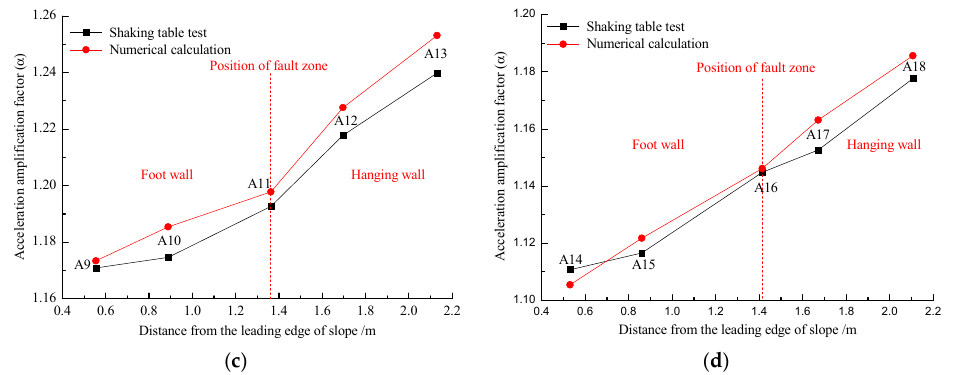
Figure 13. Comparison of AAFs between shaking table test and numerical simulation under influence of Minxian wave, with input PGA of a = 0.1 g at ( a ) slope surface, ( b ) vertical section, ( c ) L–W interface and ( d ) W–M interface.